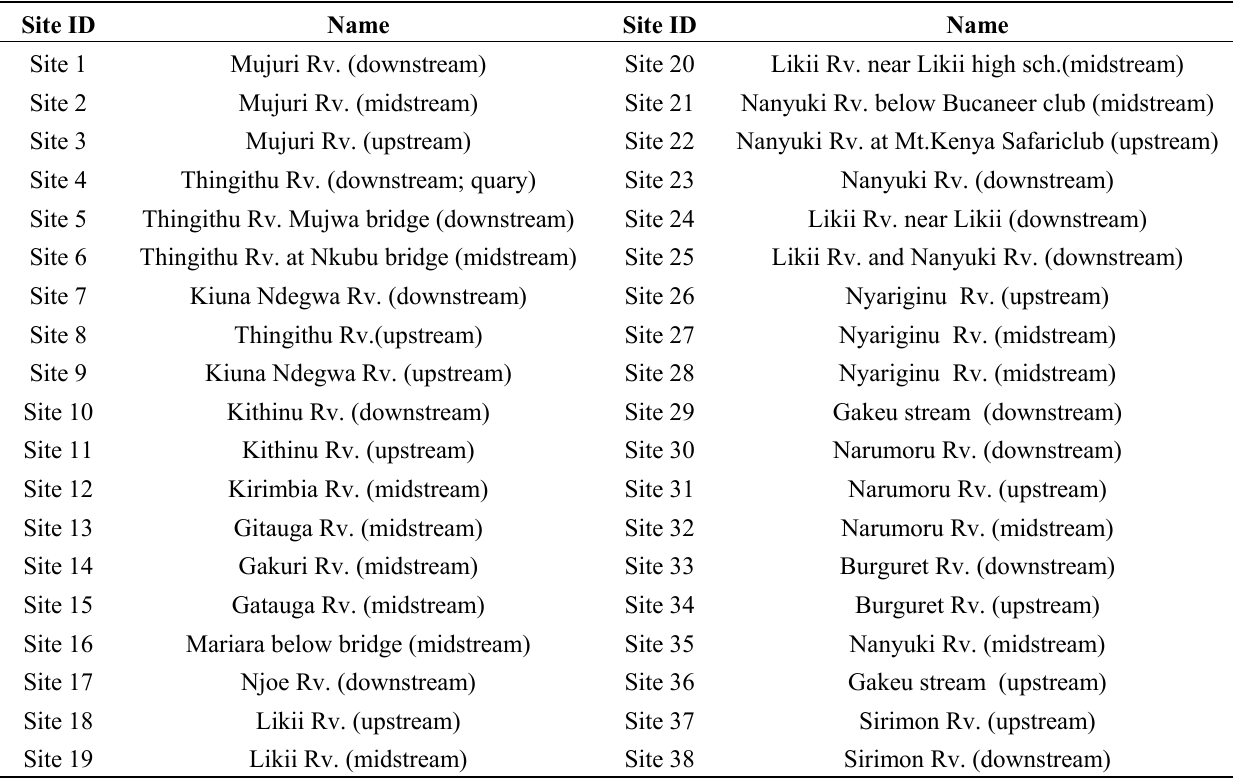
Table 1. Sampled sites (Site ID) and the respective